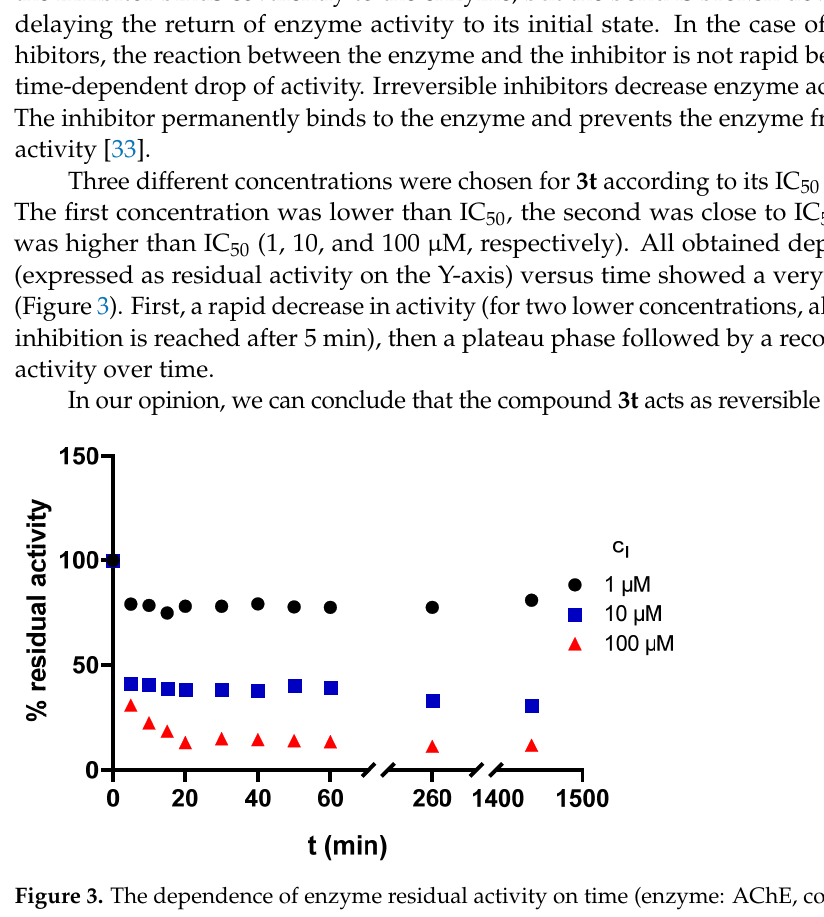
Figure 3. The dependence of enzyme residual activity on time (enzyme: AChE, compound 3t